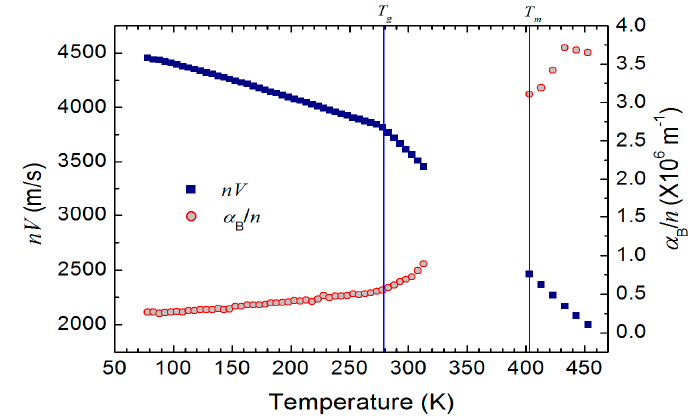
Figure 4. Temperature dependence of nV and α B / n . The glass transition temperature ( T g ) and the melting point ( T m ) are denoted by the vertical lines. The data are missing in a temperature range of 320 K–400 K due to crystallization.